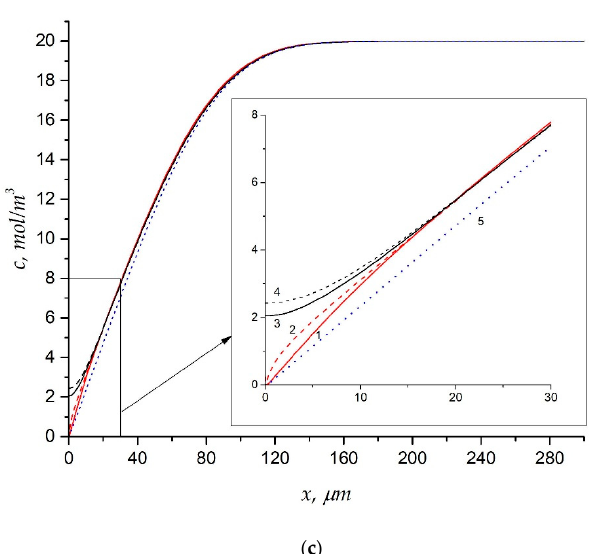
Figure 13. Concentration profiles near a heterogeneous (1–4) and a homogeneous (5) CEM. The fraction of conductive area for the heterogeneous membrane is 0.1 ( a ), 0.2 ( b ) and 0.5 ( c ). The positions of the cross-sections for which the profiles are calculated are shown in Figure 12; the first cross-section is at 550 μ m from the entrance; the intermembrane distance h = 1000 μ m; the average flow velocity of the solution in the channel between the membranes is 0.08 cm·s − 1 ; the length of the conductive surface regions is fixed: a = 10 μ m.